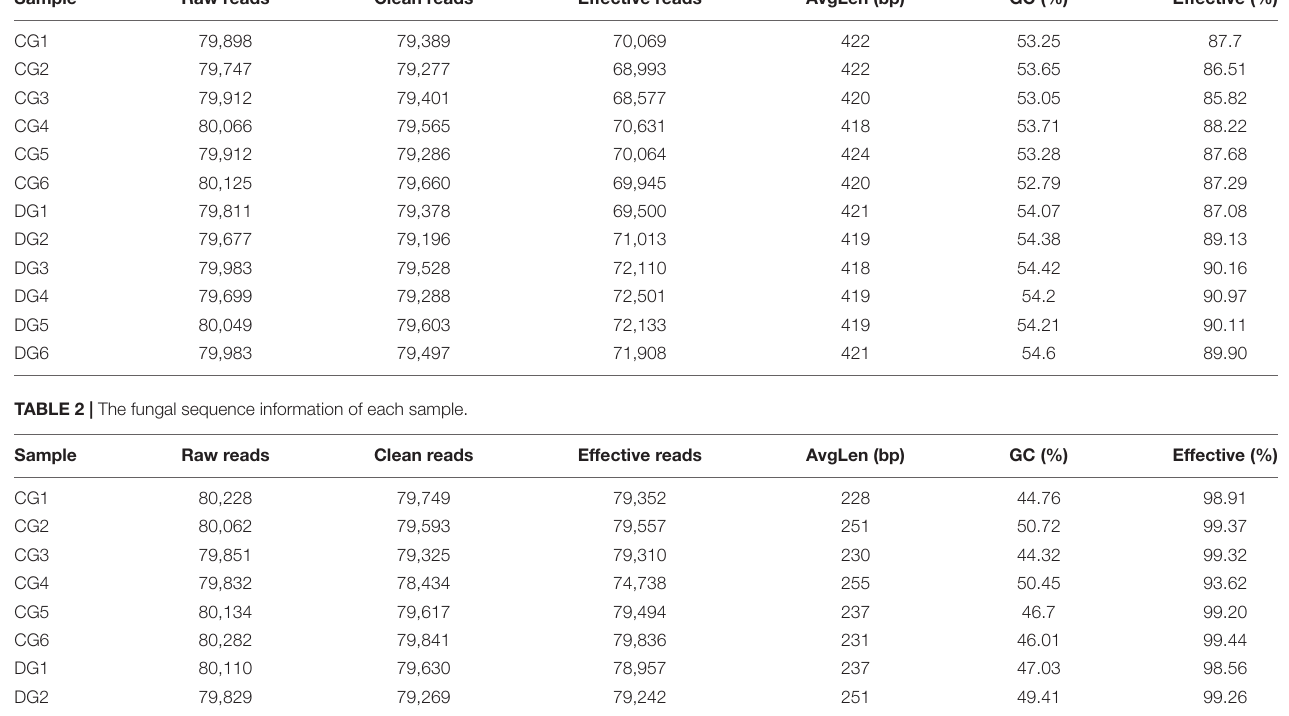
TABLE 1 | The bacterial sequence information of each sample. Sample